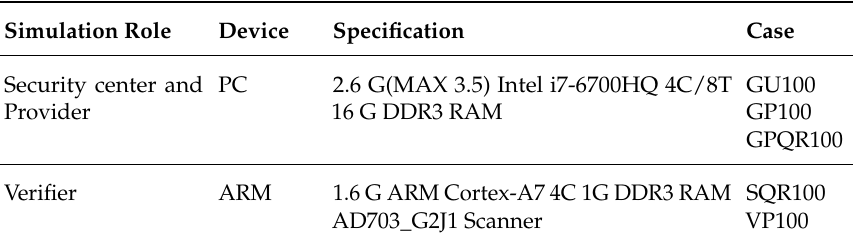
Table 2. Experimental device